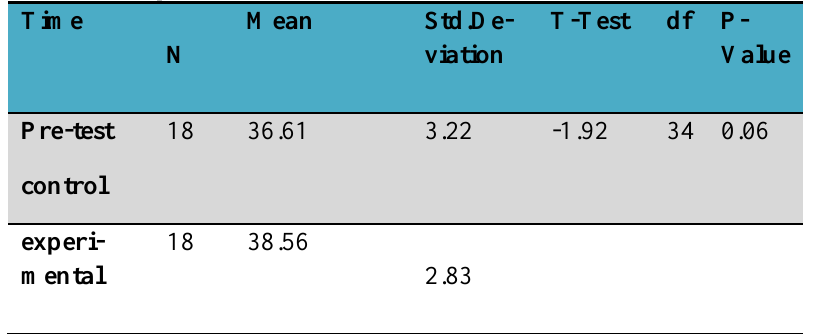
Table 2 . Independent T Test of